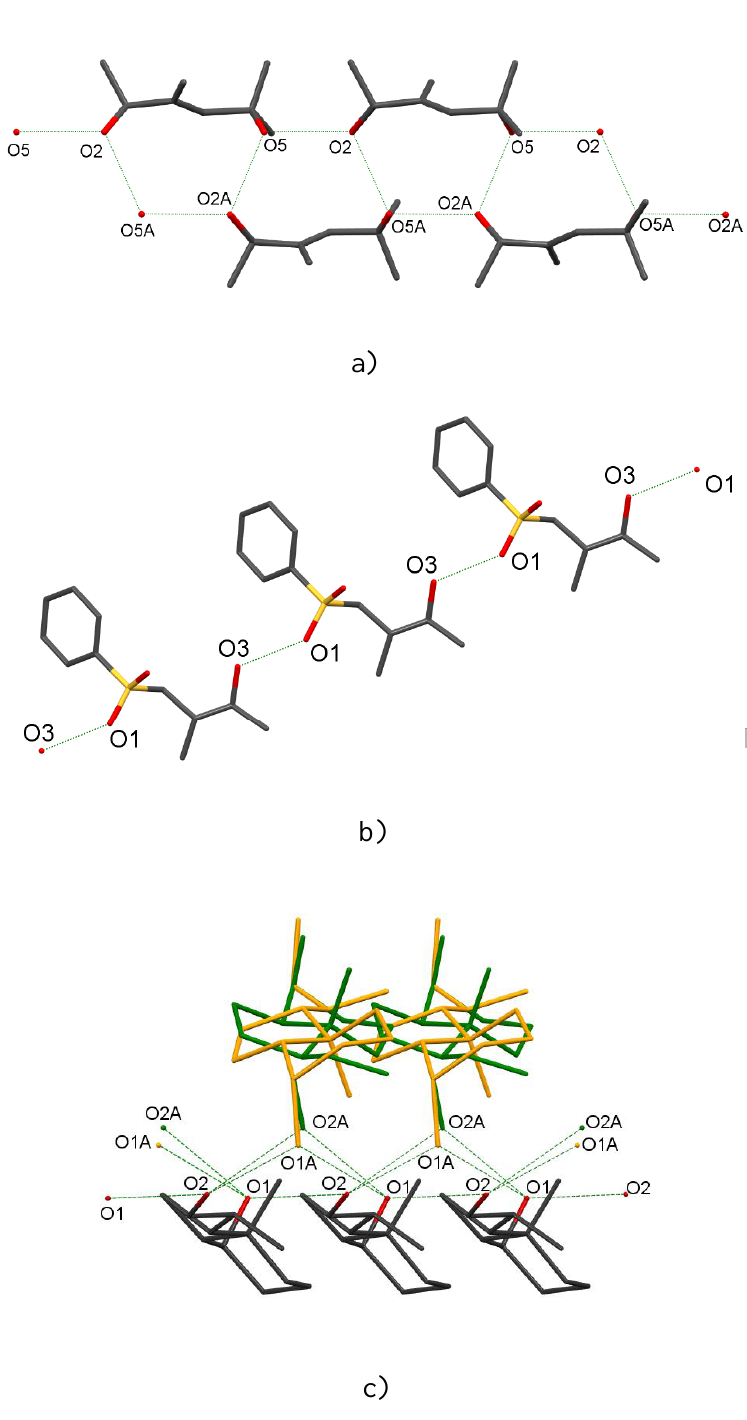
Figure 4. Infinite hydrogen bond motifs in the crystal structures of (a) 1 , (b) 2 , and (c) 3 . The hydrogen atoms were omitted for clarity.